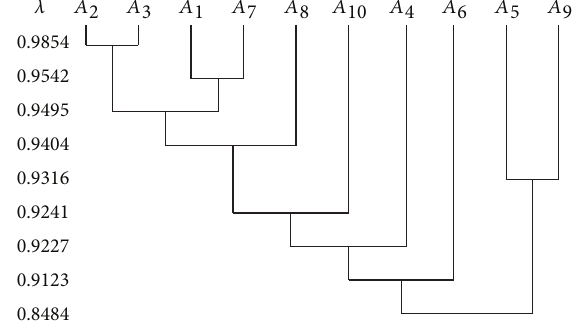
Figure 1: The clustering result of 10